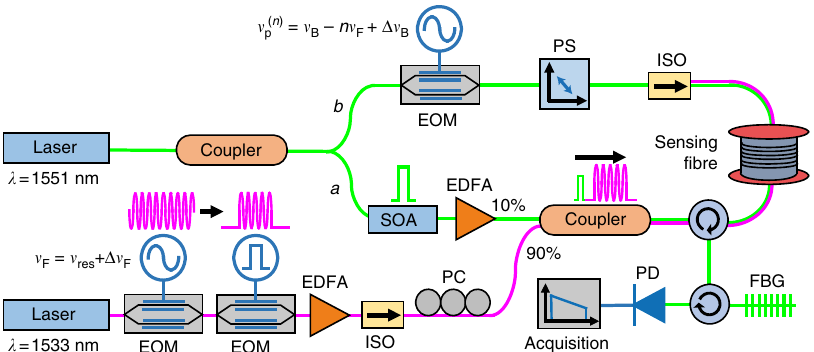
Fig. 2 Experimental setup for the distributed measurement of forward stimulated Brillouin scattering. Schematic diagram of the apparatus used to measure the spatially resolved spectrum of forward stimulated Brillouin scattering (FSBS). The FSBS activation light is represented as the magenta path ( λ = 1533 nm) and the probing system based on backward stimulated Brillouin scattering (BSBS) is represented as the green path ( λ = 1551 nm). The sensing fi bre is 730 m-long and consists of a 30 m uncoated segment spliced between two coated segments of 500 m and 200 m respectively. The components are labelled as follows: EOM electro-optic modulator, ISO isolator, PC polarisation controller, EDFA erbium-doped fi bre ampli fi er, SOA semiconductor optical ampli fi er, PS polarisation switch, PD photodetector, FBG fi bre Bragg grating. The mathematical symbols are de fi ned as follows: v res , the selected FSBS resonant frequency, ν F, frequency of the intensity modulation and Δ v F, scanned frequency detuning for FSBS activation; ν B , Brillouin frequency shift of BSBS; ν ð n Þ p , frequency of the intensity modulation and Δ ν B , scanned frequency detuning for BSBS